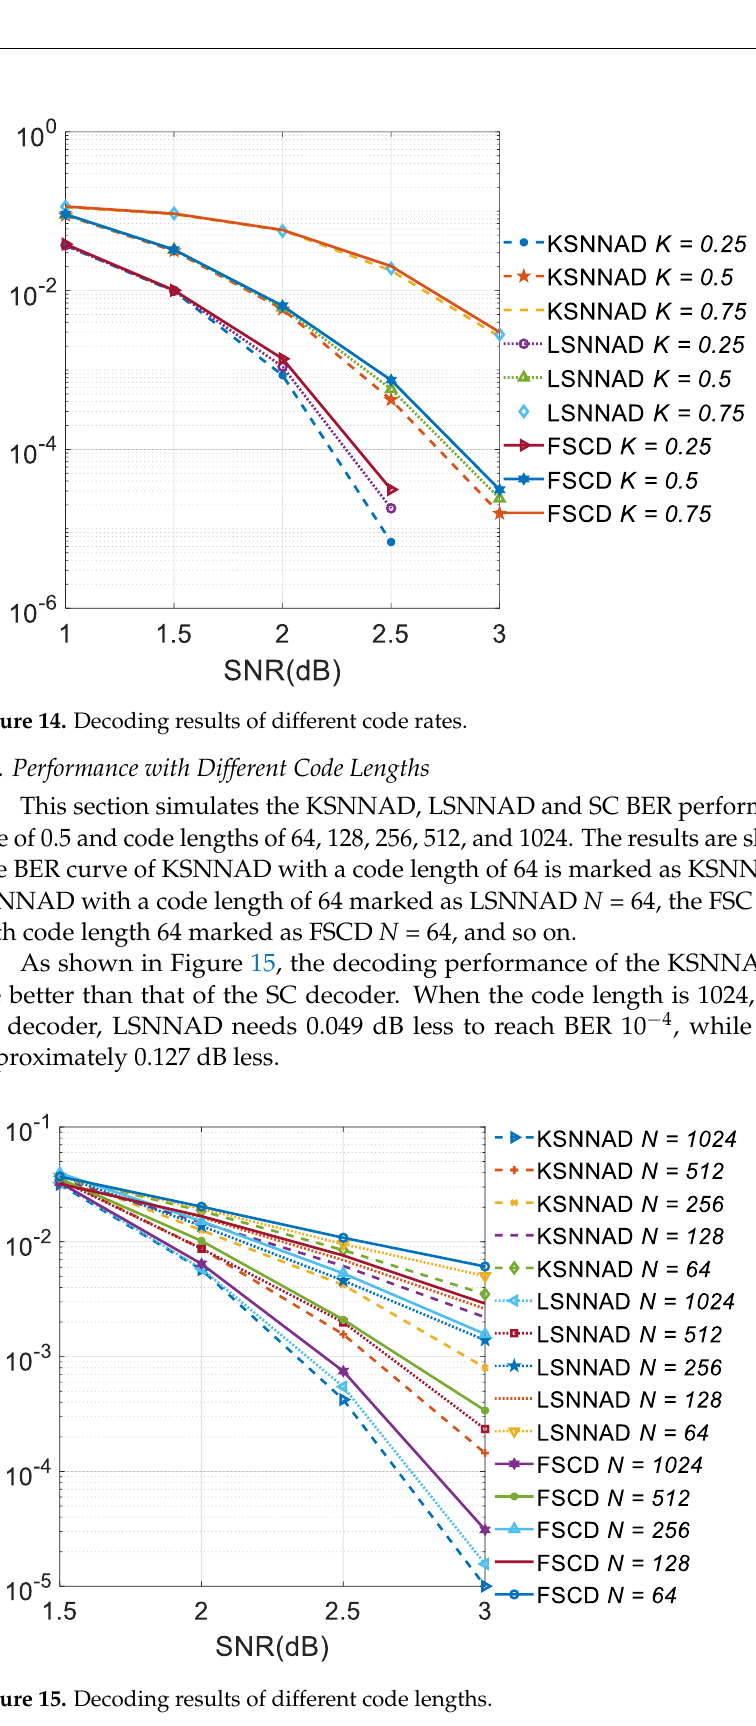
Figure 15. Decoding results of different code lengths. 4.4. Performance Comparison under AWGN Channel This section simulates the BER performance comparison of different algorithms with a code length of